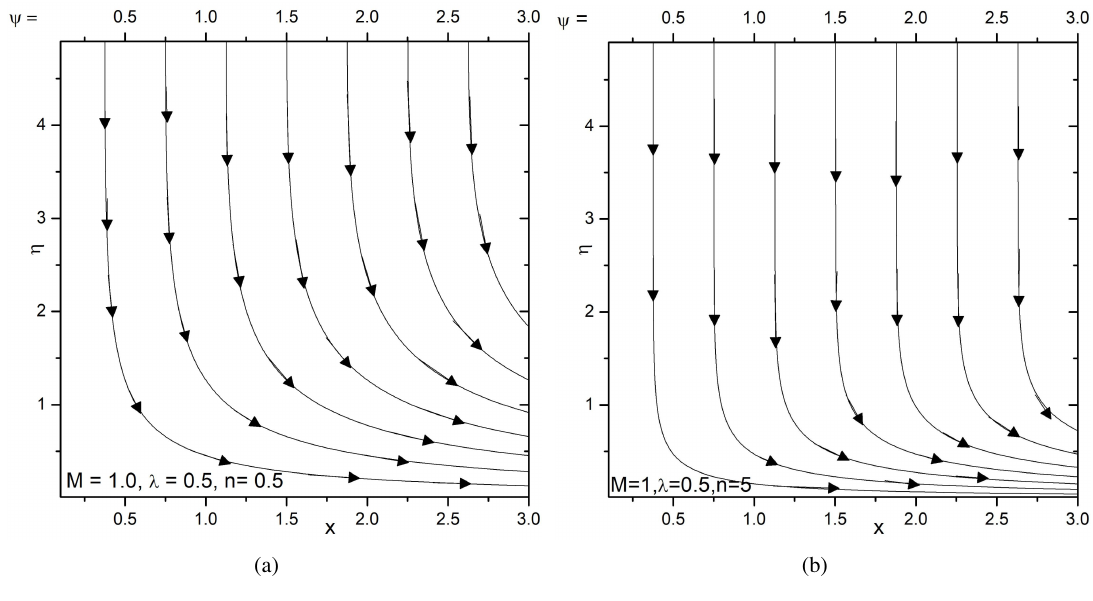
Fig. 10 The streamline of the flow for (a) n = 0.5 and (b) n =